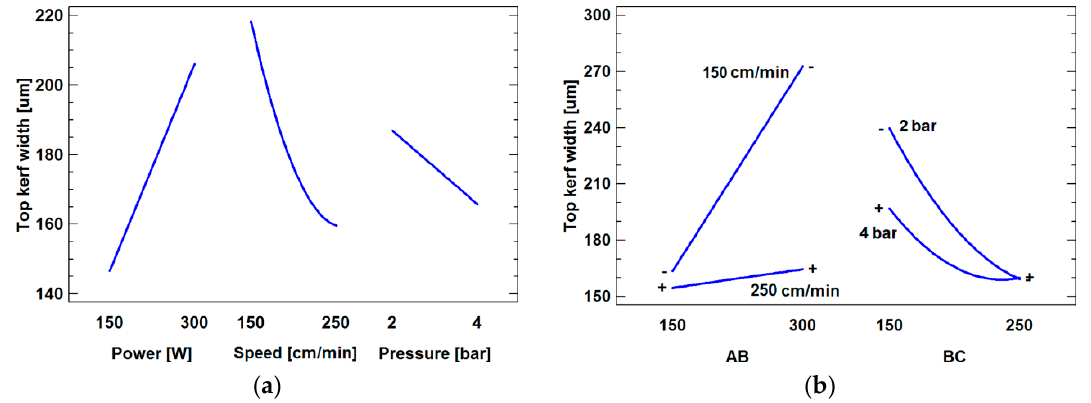
Figure 10. ( a ) Main effects and ( b ) interaction plots of top kerf width. A: laser power; B: cutting speed; C: oxygen pressure. Polynomial trendlines have been used to fit perpendicularity tolerance data.